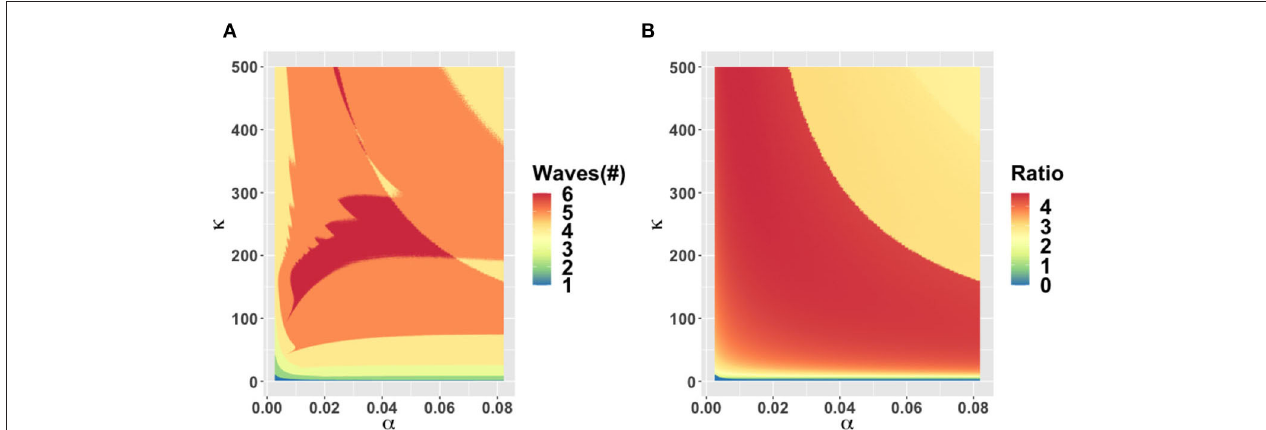
FIGURE 3 | Parameter plane showing model dynamics as they vary with changes in the rate α at which socio-economic losses accrue and the rate κ that controls the social learning rate, for the number of COVID-19 waves (A) and the ratio of peak height of the second wave to the first wave peak (B) . Other parameters are at baseline values ( Table 1 ).